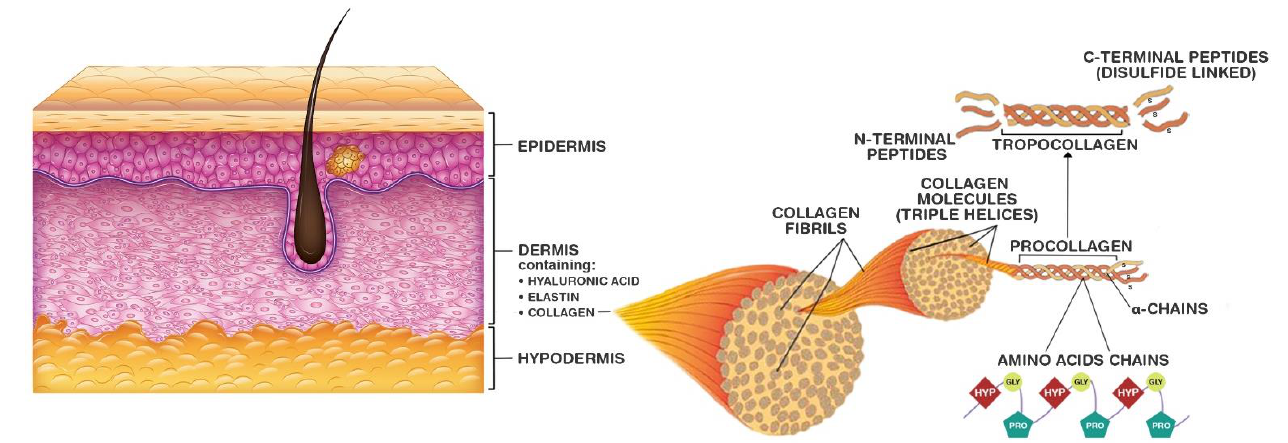
Figure 2. Skin-collagen-molecular structure. Adapted with permissions from: (1) Tang et al., Journal of Voice, published by Elsevier Inc. (Amsterdam, The Netherlands), 2017; (2) Reilly and Lozano, Plastic and Aesthetic Research, published by OAE Publishing Inc., 2021 (©2021 MINERVA Research Labs Ltd. (106 New Bond St. London, UK) all rights reserved) [29,30] .